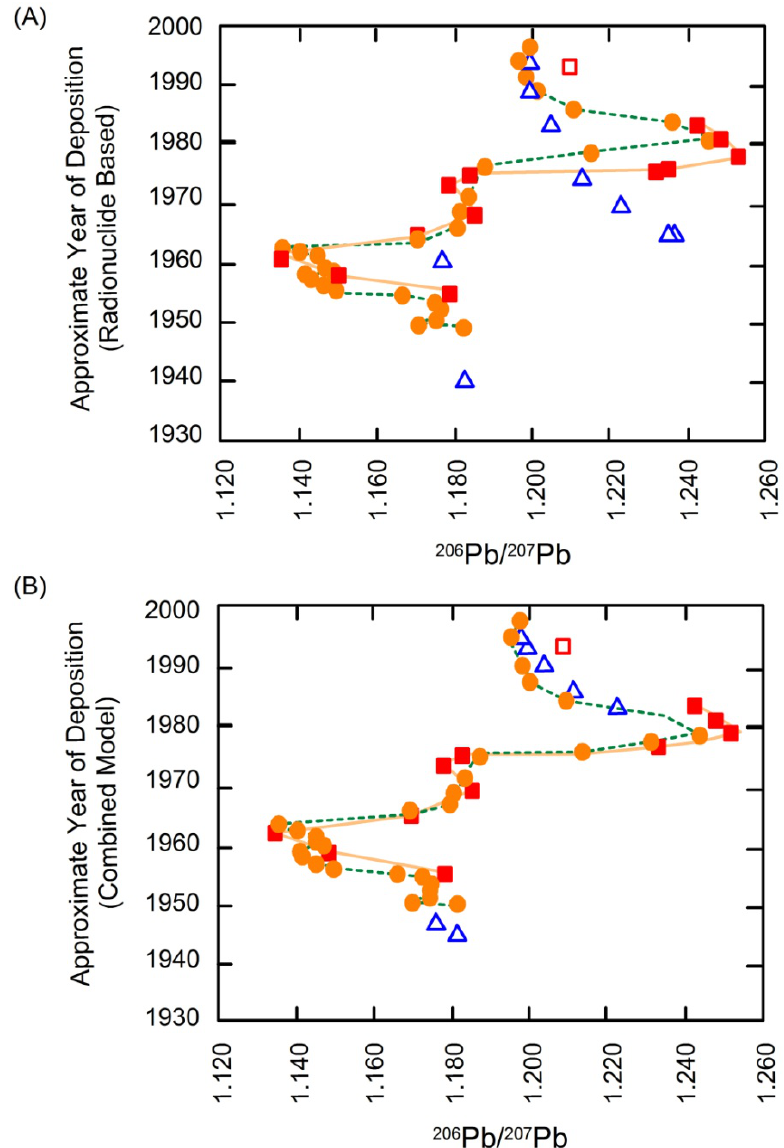
Figure 7. Vertical (temporal) trends in 206 Pb/ 207 Pb ratios within three cores obtained from reservoirs at three different locations along the upper Hudson River. Red squares represents samples from mile post (mp) 188.5 (upstream), orange circles from mp 163.6 (downstream), and open blue triangles from samples collected at mp 169 in 1995 ( A